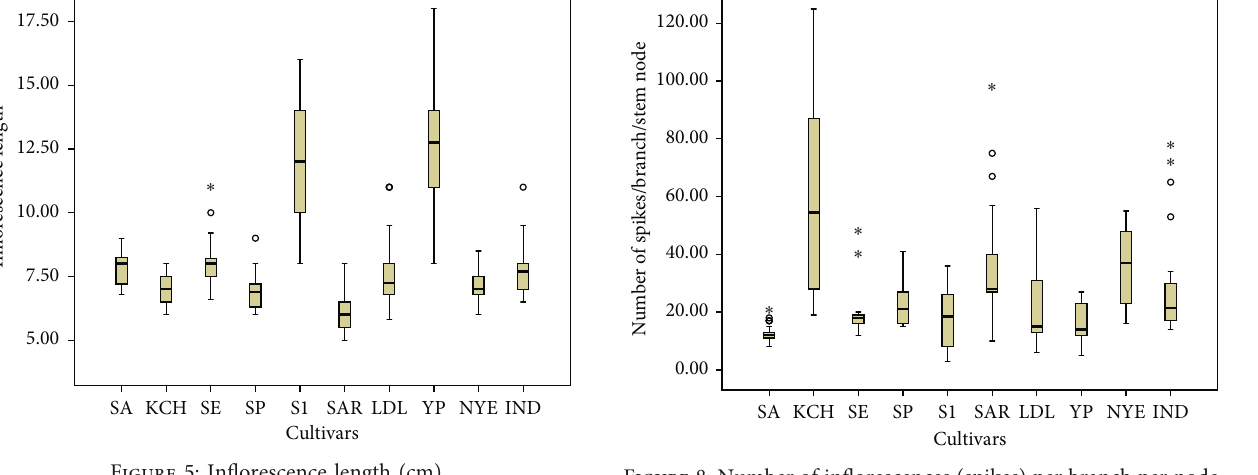
Figure 8: Number of inflorescences (spikes) per branch per node.